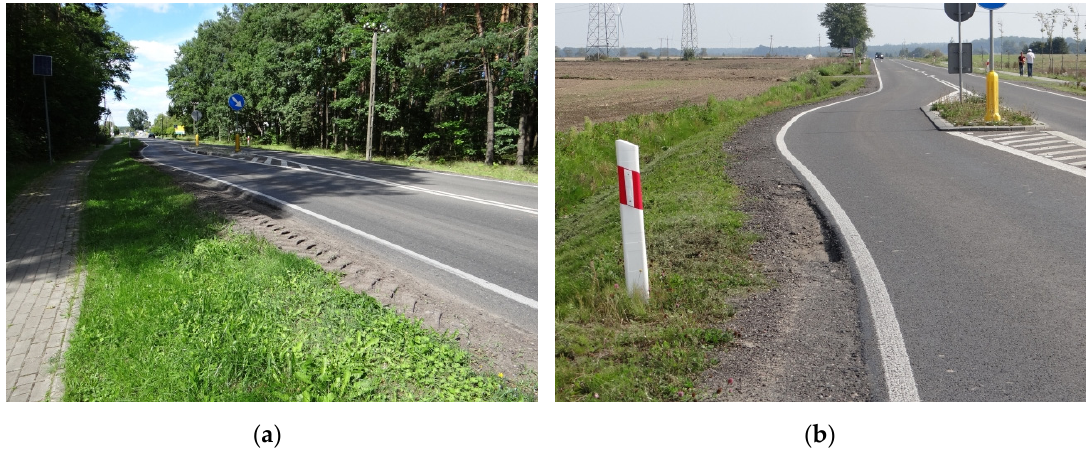
Figure 26. Examples of design errors over the length of the deflected lane section: ( a ) deterioration of the dirt shoulder over the length of lateral deflection due to the lack of strengthening; ( b ) asphalt millings placed on the dirt shoulder as an overrun area for oversize agricultural equipment along the horizontal carriageway deflection.